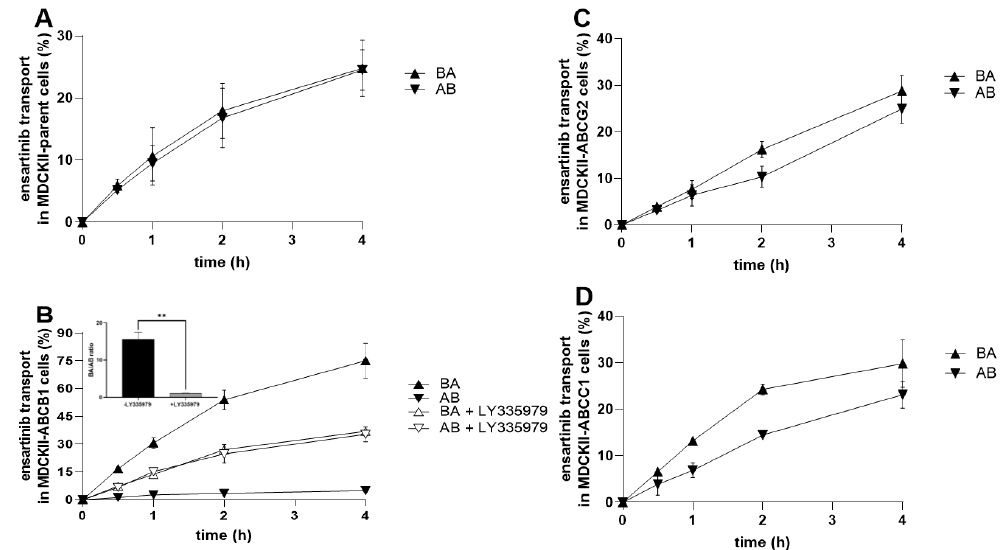
Figure 9. Transport of 1 µM ensartinib across MDCKII-parent ( A ), MDCKII-ABCB1 ( B ), MDCKII-ABCG2 ( C ), and MDCKII-ABCC1 ( D ) cell monolayers. LY335979 (1 µM) was used as a control ABCB1 inhibitor. Cell monolayers were exposed to ensartinib or a combination of ensartinib with a model inhibitor in the donor compartment, and sampling was performed in the acceptor chambers at selected time points. Ensartinib levels were assessed by HPLC-MS/MS. Transport ratios ( r ) were calculated by dividing the percentage of ensartinib transported in the BA direction by that in the AB direction 4 h after drug addition. The statistical significance of changes in r ratios in the absence/presence of the model inhibitor was analyzed using the two-tailed unpaired t -test (** p < 0.01).